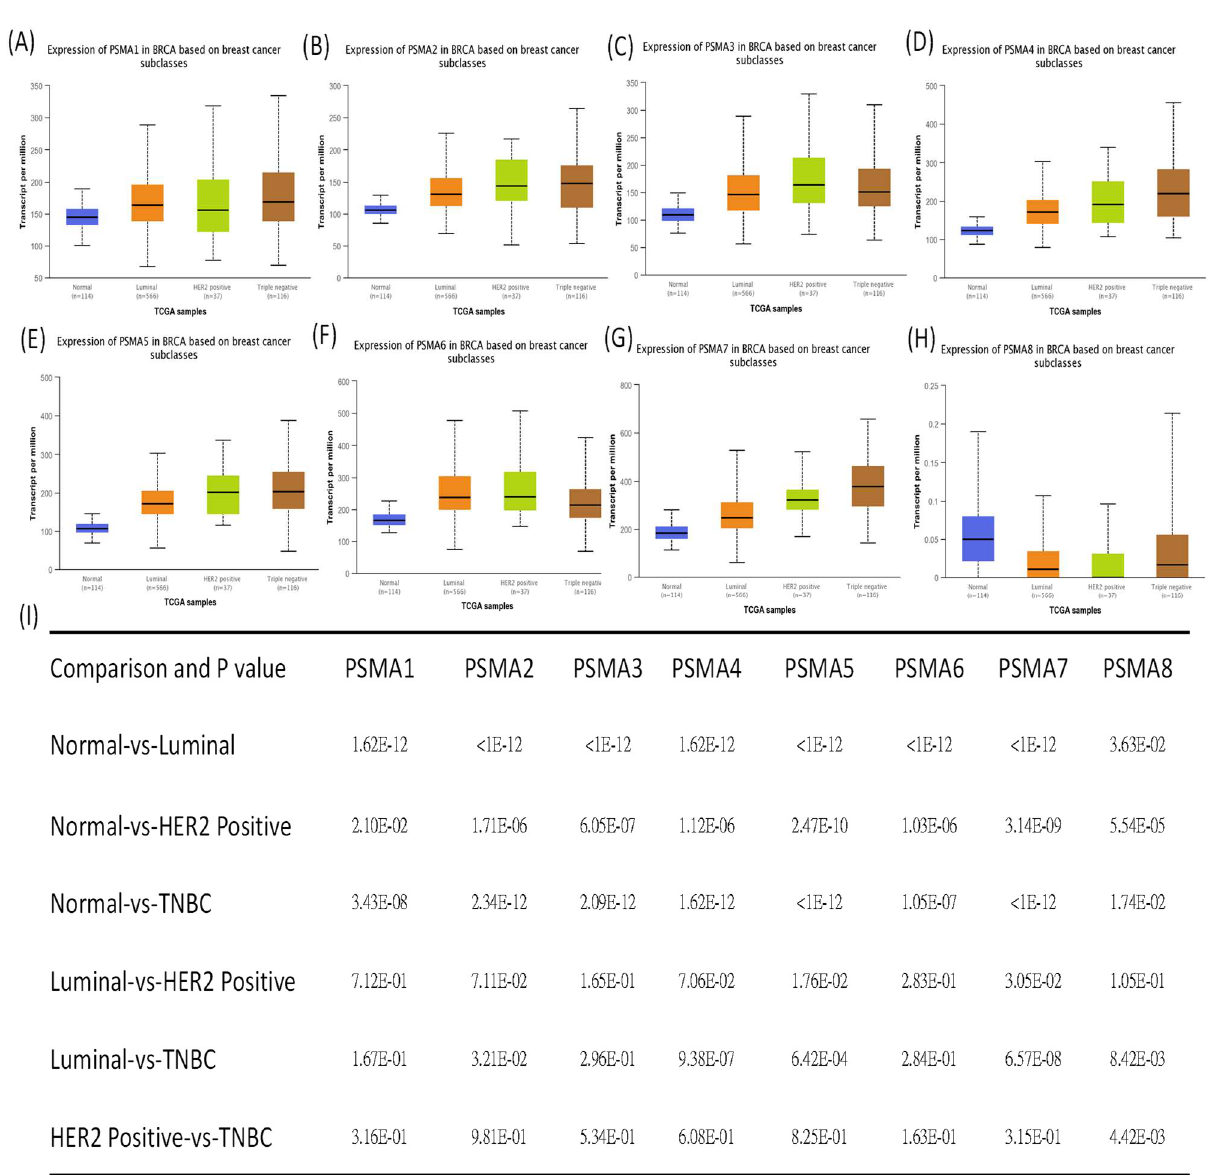
Figure 1: Proteasome 20S subunit alpha (PSMA) gene family transcription levels in different stages of breast cancer (BRCA) patients (UALCAN analysis). ( A – H ) Box plot of PSMA gene family and primary tumor (BRCA) tissues. The box plot shows comparisons of the expressions of TCGA data from the PSMA gene family in different stages of breast cancer, including normal samples ( n = 114), luminal ( n = 566), HER2-positive ( n = 37), and triple-negative tumors ( n = 116). Statistical significance is represented by p < 0.05. ( I ) The table shows relative expression levels of PSMA family genes in normal samples and different BRCA subtypes; p < 0.05 was considered statistically